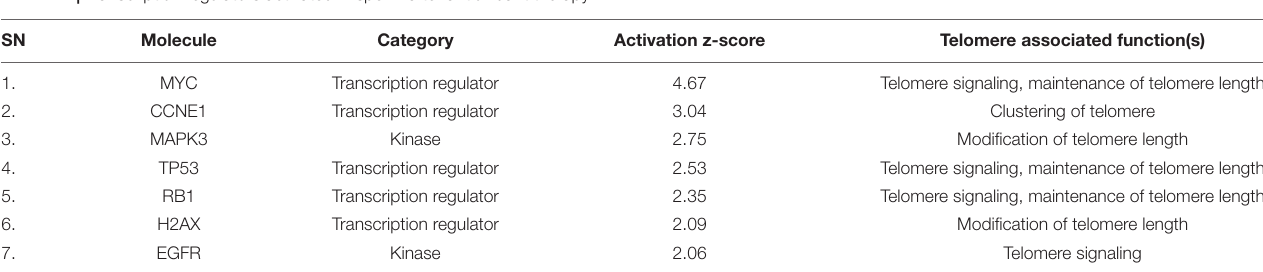
( Table 1 ). Epidermal growth factor receptor signaling pathway